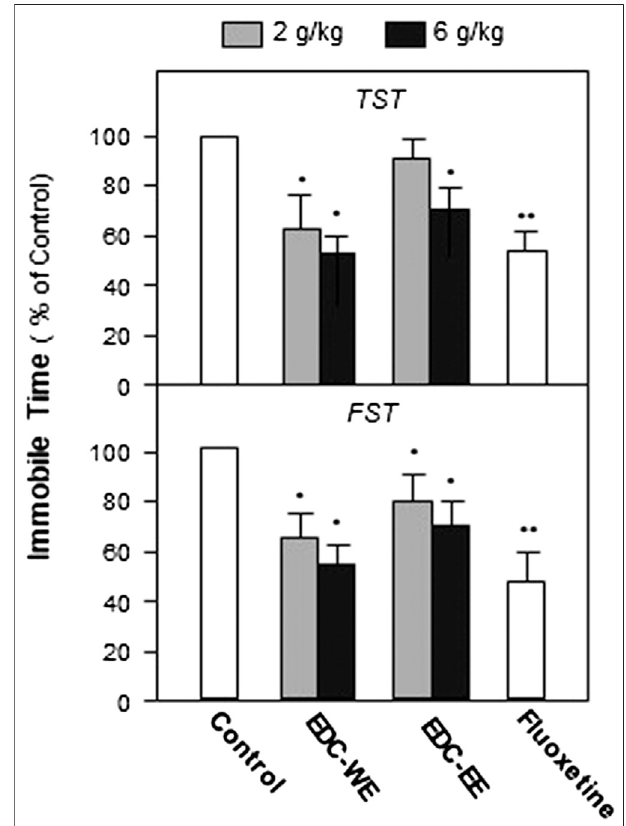
FIGURE 1 | Extracts of Elaphuri Davidiani Cornu (EDC) improved the depression-like behaviors of mice. After 7-days treatment with the EDC aqueous (EDC-WE) and ethanol extracts (EDC-EE), groups of mice were subjectedtothetail-suspension(TST) andforced-swimmingtests(FST). Fluoxetinewasusedasapositivecontrol.EachEDCextractwasadministered at two doses of 2 and 6 g/kg of the converted to crude EDC material). Values are expressed in percentages of the control group (no-drug treatment group), as mean ± SEM ( n (cid:1) 8). * p < 0.05, ** p < 0.01 (compared with the control